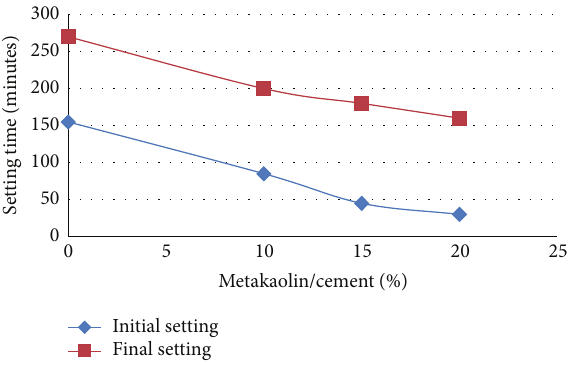
Figure 3: The setting time of MK modified cement paste with 0% polymer.